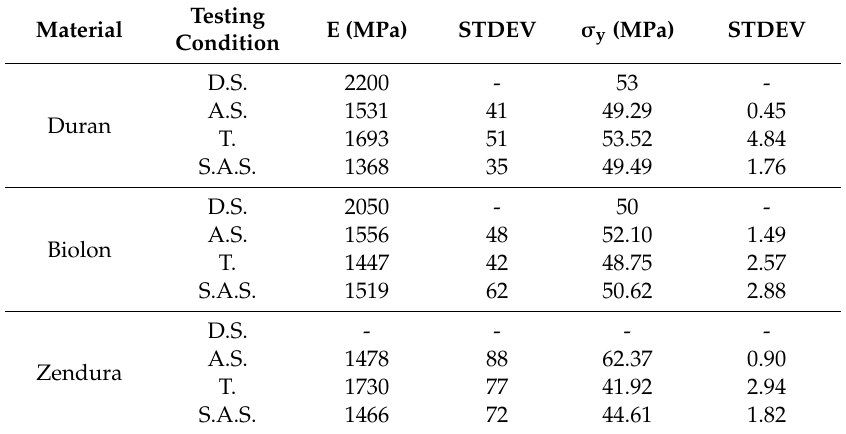
Table 4. Results of tensile tests for elastic modulus E and tensile yield stress σ y (mean value and standard deviation STDEV).